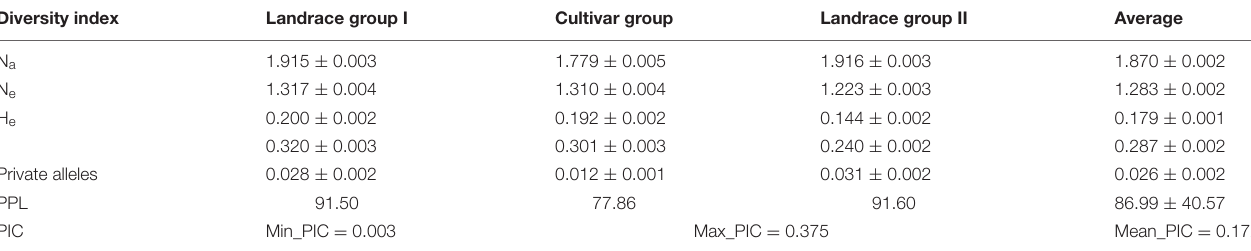
TABLE 2 | Genetic variation among three groups identified by structure analysis on a diversity panel of 369 Iranian hexaploid wheat landraces and cultivars.